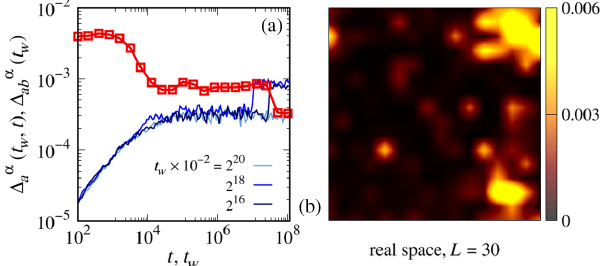
FIG. 9. Connection between landscape structure and aging dynamics for sample α at Z ¼ 600 . (a) Blue lines: Aging dynamics for a single clone a undergoing activated event from ð t ; t Þ . Red square: The distance group to group via MSD Δ α w a n m Δ α ð t Þ between clone a and a randomly chosen clone belonging w ab jumps discontinuously after the rearrangement. (b) The to group m cage-relative displacements by the configurations of clone a measured before and after the activated event detected in (a). This displacement field is very similar to the snapshot of Δ α in Fig. 6(c1).